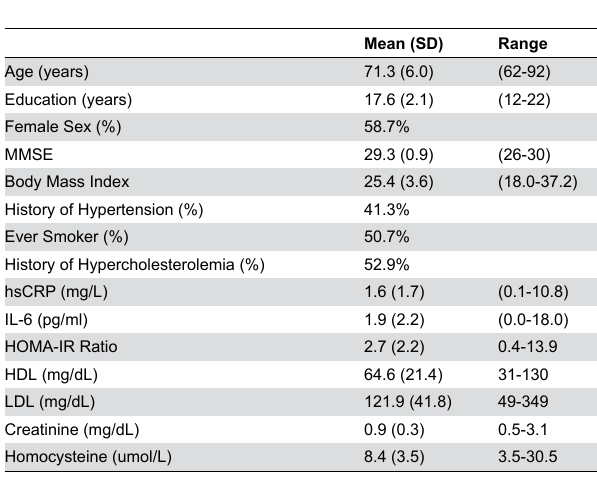
Table 1. Demographic and Health